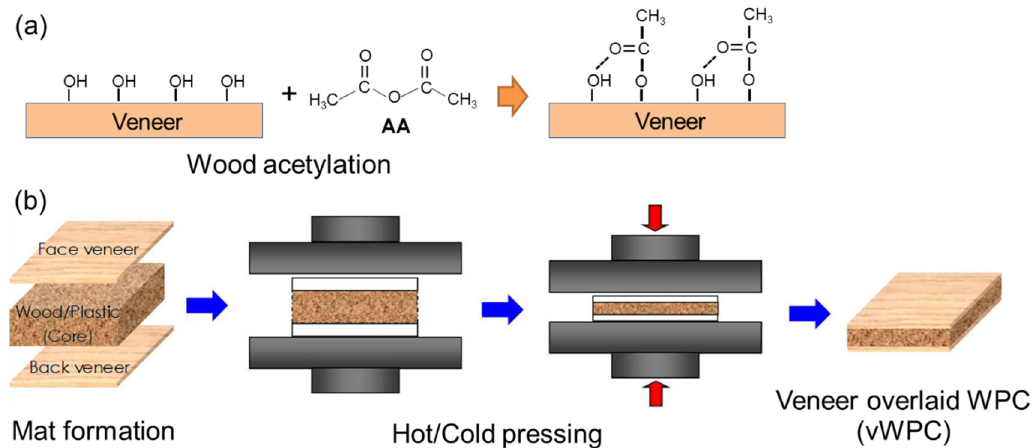
Figure 1. Scheme of ( a ) wood acetylation and ( b ) adhesive-free vWPC processing.